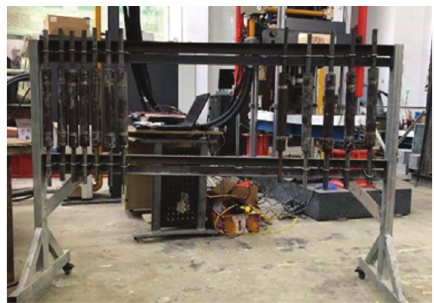
Figure 2: The sleeves with different grouting material strength bolted into the